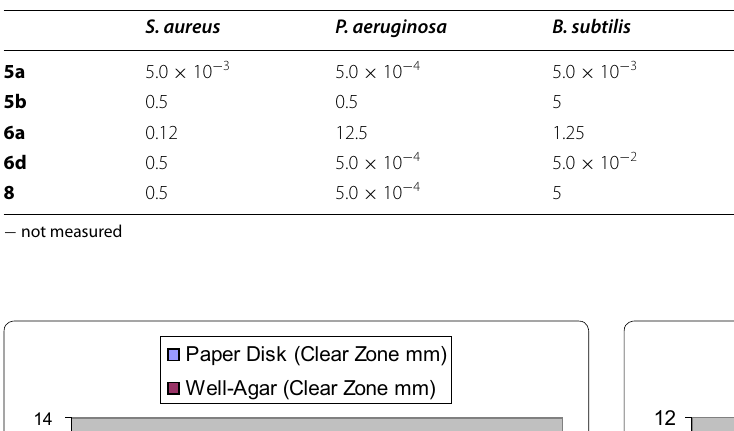
Table 2 MIC values in ppm of compounds 5a, 5b, 6a, 6d and 8